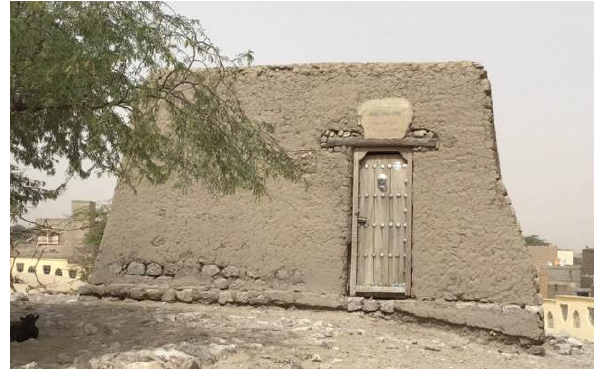
Figure 10. Mausoleum of Cheik Alpha Moya in January 2020. © Essayouti B.